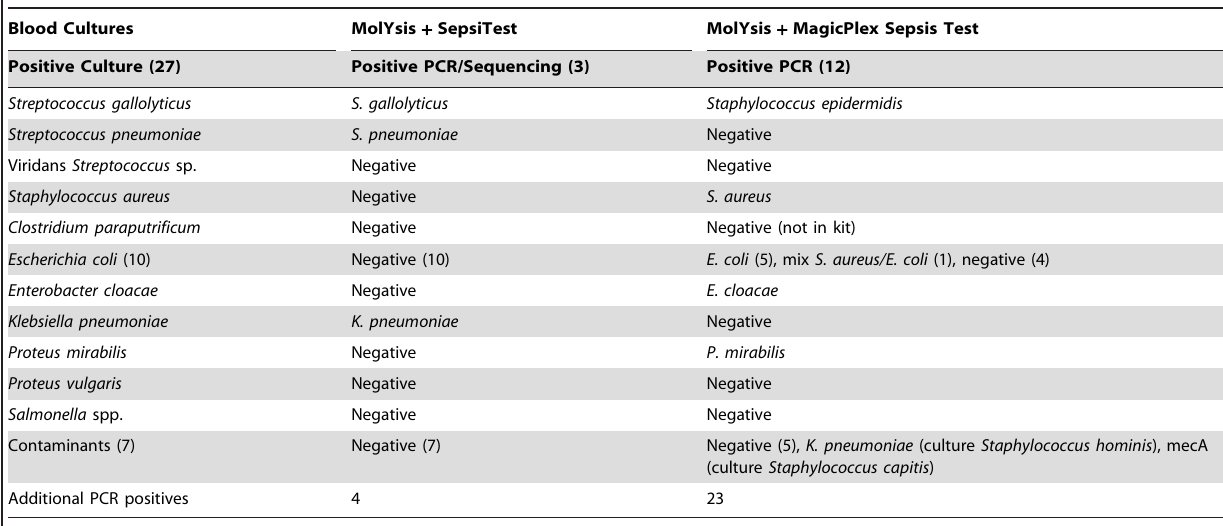
Table 4. Overview of the results obtained with the molecular assays (SepsiTest and MagicPlex Sepsis Test) in comparison to blood culture